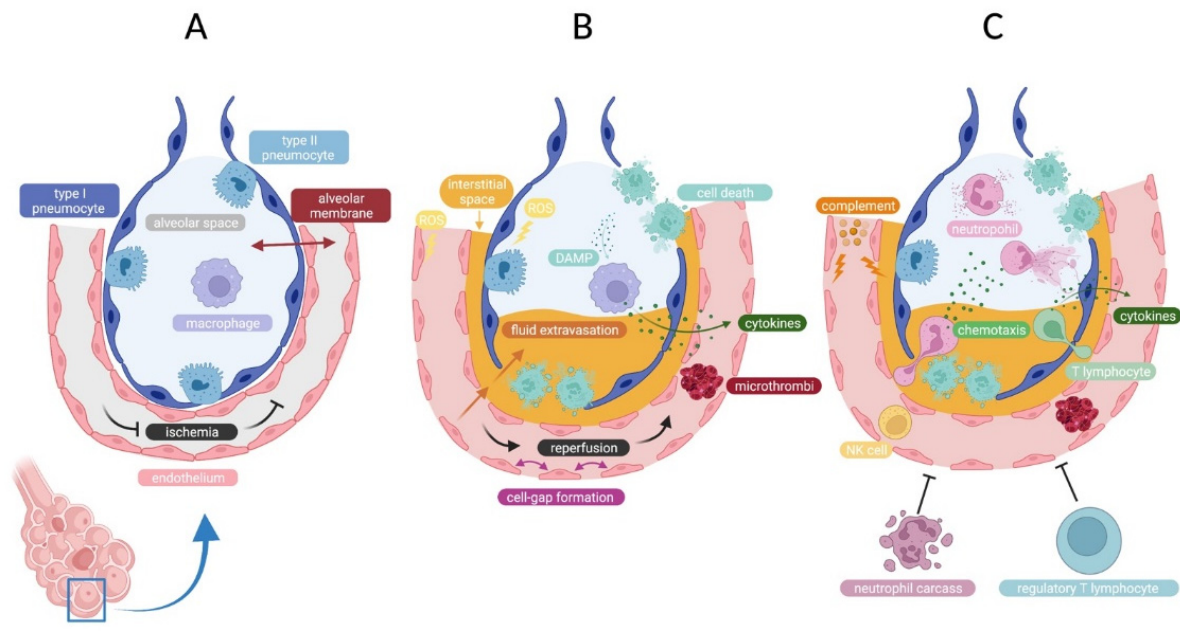
Figure 7. Overview of ischemia-reperfusion injury (IRI) at the cellular level in the lung graft during and after LTx. ( A ) Cessation of flow or ischemia in the alveolar capillaries sets off IRI. ( B ) Phase of donor-derived inflammation initiates the innate immune response after reperfusion. ( C ) Phase of recipient-derived inflammation that further precipitates injury in the lung. (Created with BioRender.com). DAMP = damage associated molecular pattern; NK = natural killer; ROS = reactive oxygen species.